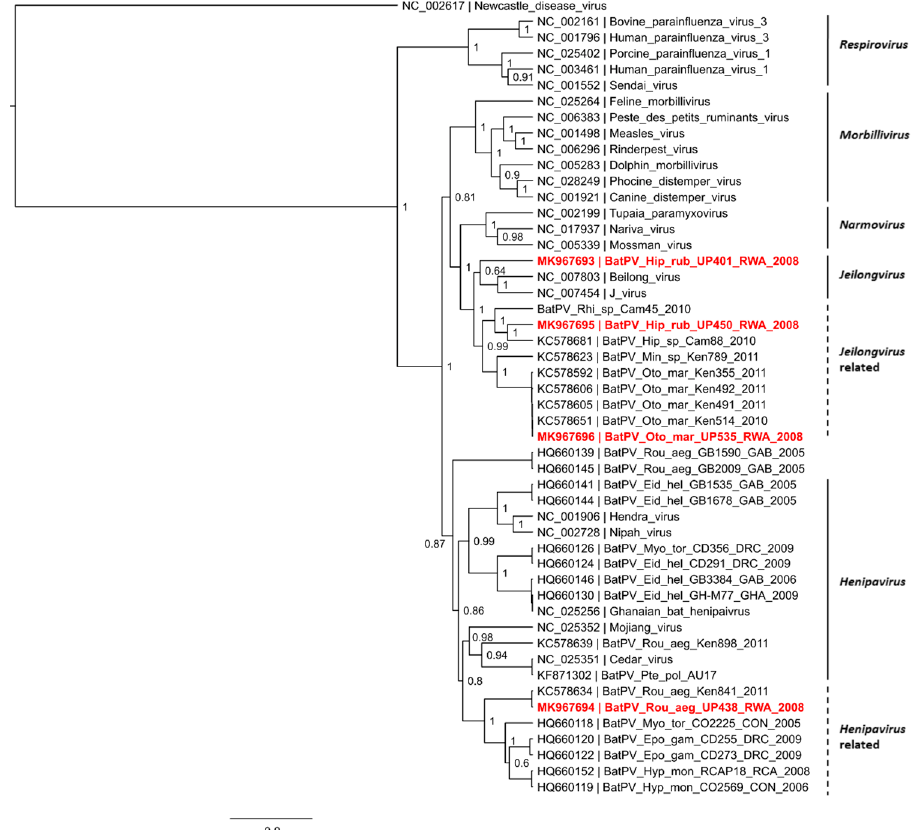
Figure 3. Phylogeny of the 439 nucleotide length sequences of the polymerase (L) gene of paramyxoviruses detected in bats from Rwanda using Respiro-Morbilli-Henipavirus genus-specific primers. Bayesian phylogenetic analysis was performed using the general time reversible model using the gamma and invariant site substitution model. A proportional tree representation is provided. Newly detected sequences from this study are indicated in bold red. Newcastle disease virus was selected as the outgroup.